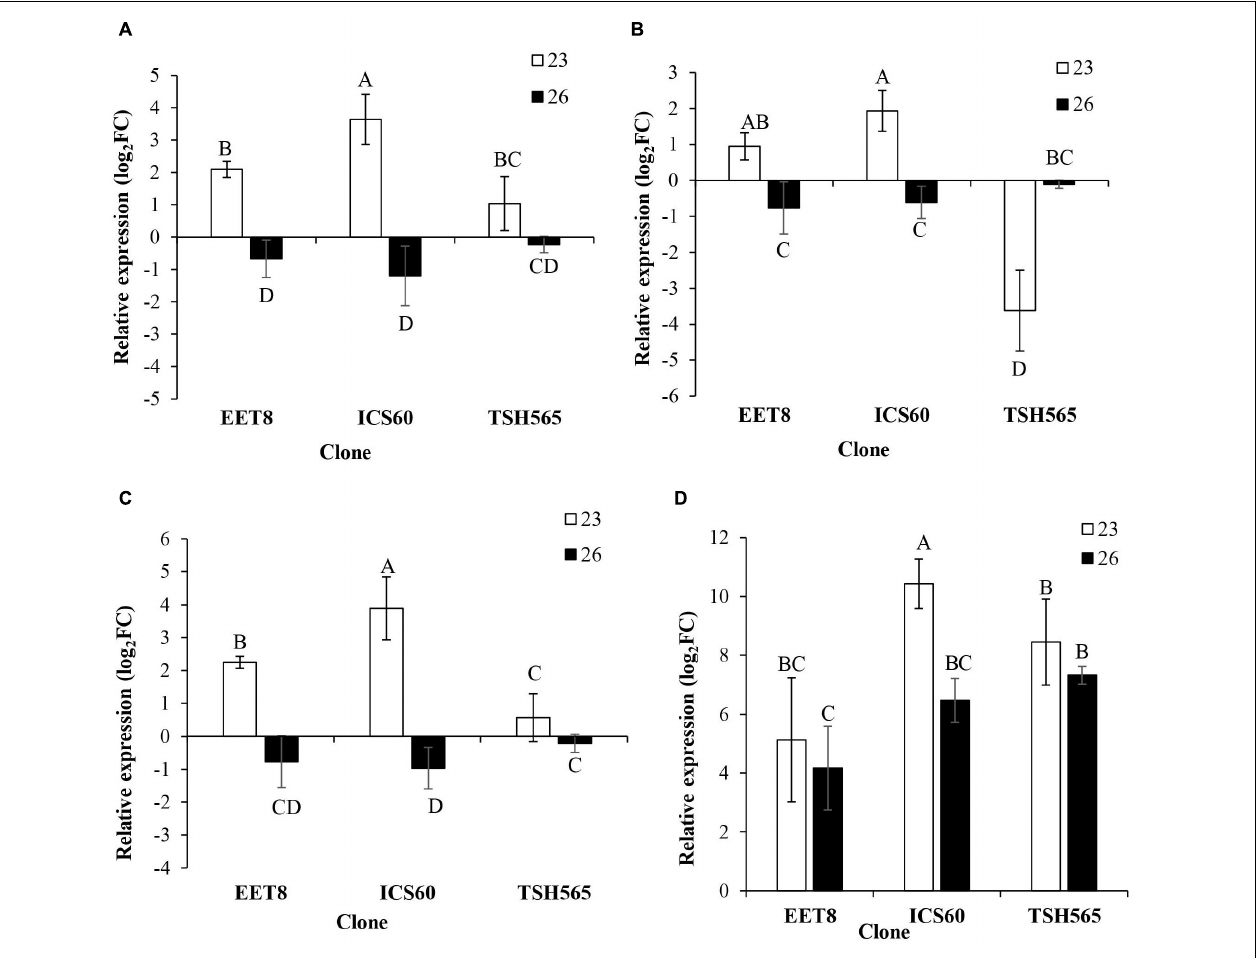
FIGURE 3 | Effect of water deficit on the transcriptional expression of genes encoding antioxidant enzymes. (A) RBOHF . (B) NTRC . (C) UDPGT . (D) SOD . Bars represent the averages of the induction factor (log2-fold change) ± standard deviation ( n = 3) relative to the control (day 0). The letters indicate statistically significant differences between days 23 and 26 of water deficit ( P <